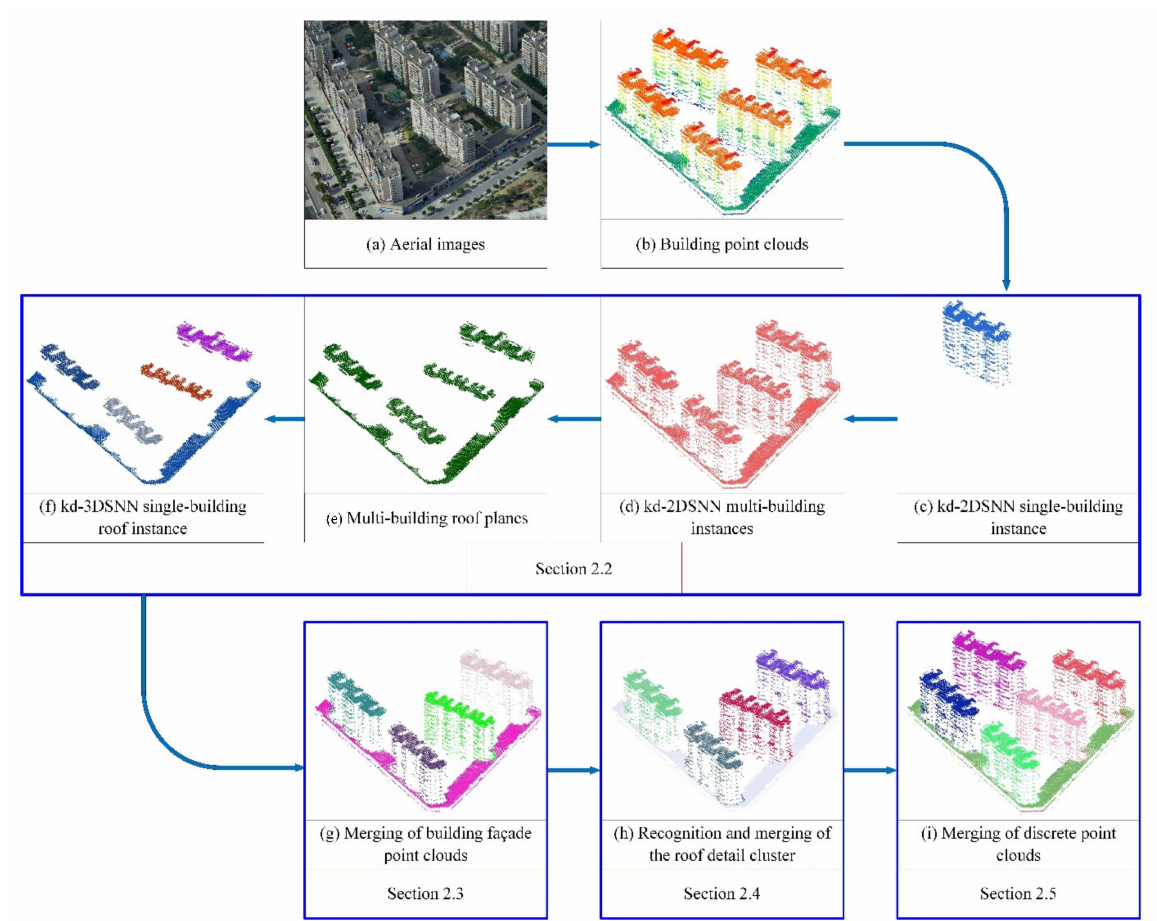
Figure 1. Illustration of the unsupervised building instance segmentation (UBIS) method: ( a ) aerial images corresponding to inputted building point clouds; ( b ) inputted building point clouds; ( c ) the output of a single-building instance; ( d ) the output of a multi-building instances; ( e ) the output of multi-building roof planes; ( f ) the output of a single-building roof instance; ( g ) the output of merging of building façade point clouds; ( h ) the recognition and merging of roof detail cluster; ( i ) the output of isolated point cloud clusters merged into building instances.